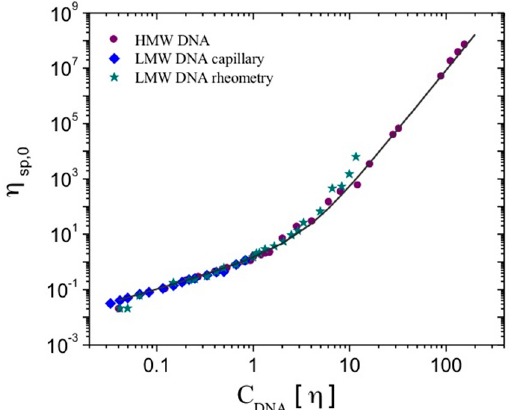
Figure 1. Dependence of the specific viscosity at zero shear rate ( η sp,o ) as a function of the overlap parameter C DNA [ η ] for low molecular weight (LMW) DNA from salmon sperm and high molecular weight (HMW) DNA from calf-thymus at different concentrations C DNA . The solid line represents the master curve expressed by Equation (3).